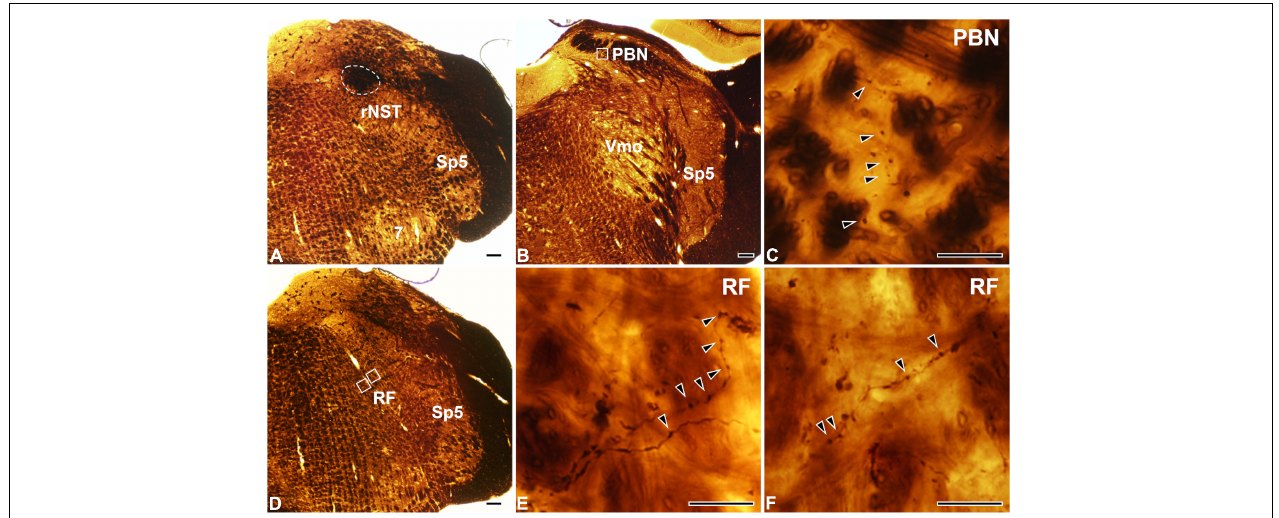
FIGURE 1 | Light micrographs showing the tracer injection site in the rostral part of the nucleus of the solitary tract (rNST; A ) and anterogradely labeled axon terminals in the parabrachial nucleus (PBN; B,C ) and the reticular formation (RF; D–F ). (A) The horseradish peroxidase (HRP) injection, outlined with a dashed line, is confined to the rNST. (B–F) Dark HRP-labeled axons and terminals (arrowheads) are observed in the central medial subnucleus of the PBN (B,C) and the medullary RF (D–F) . Panel (C) is the enlargement of the square in panel (B) . Panels (E,F) are enlargements of the medial and lateral squares, respectively, in panel (D) . Sp5, spinal trigeminal nucleus; Vmo, trigeminal motor nucleus; 7, facial nucleus. Scale bars, 200 µ m in panels (A,B,D) and 20 µ m in panels (C,E,F)